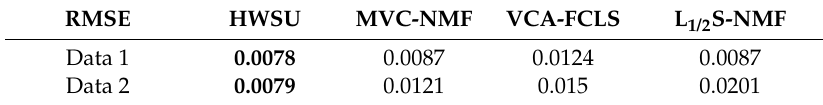
Table 5. The RMSE of unmixing results using HWSU, VCA-FCLS, MVC-NMF, L 1/2 S-NMF.